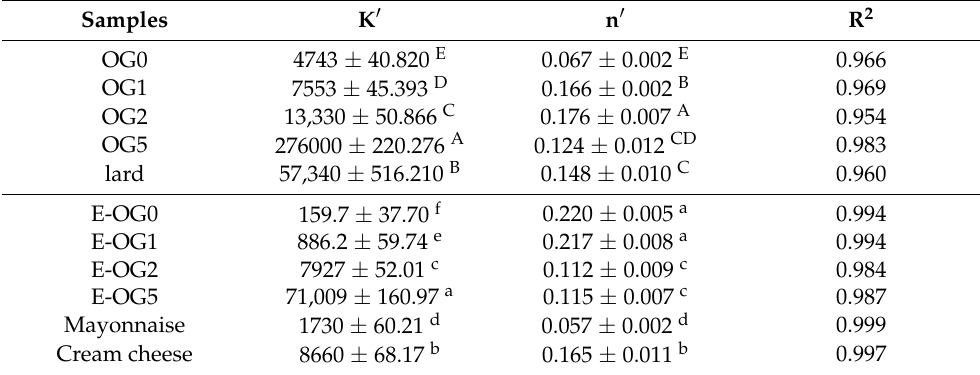
Table 2. The Power Law parameters (K’ and n (cid:48) ) of the oleogels and emulsions. Samples